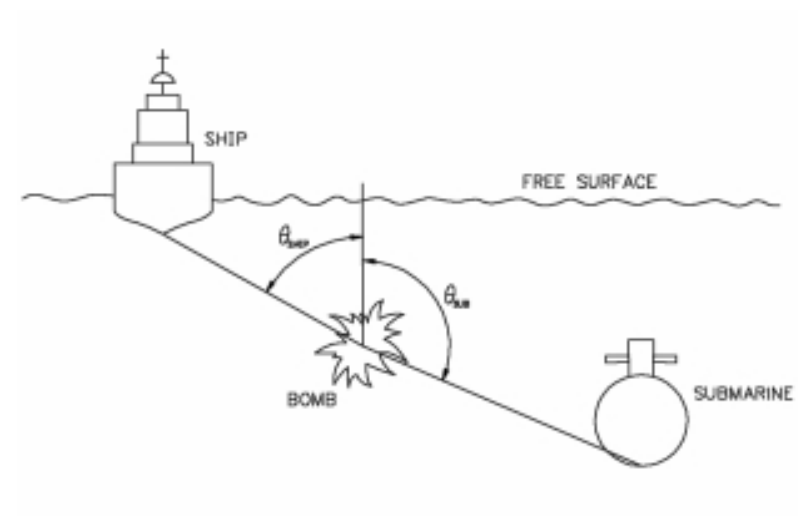
Fig. 4. Diagram for θ used in KSF calculation.